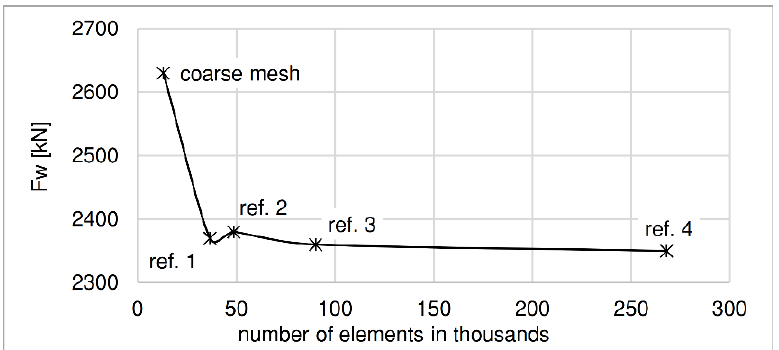
Figure 4. Mesh independence test.